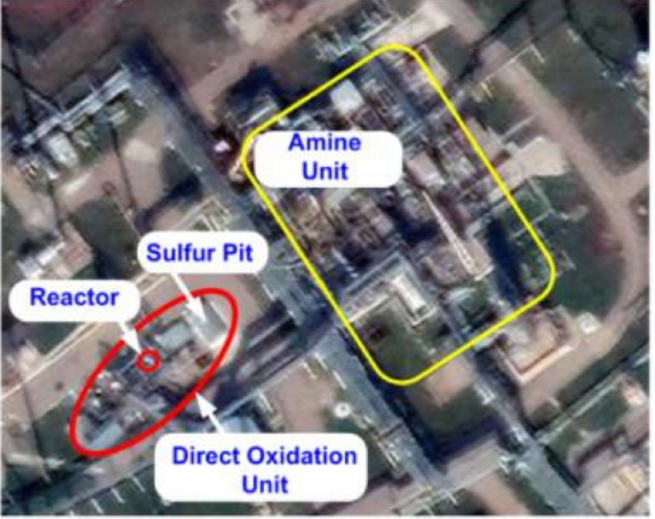
Figure 22. Bavly gas shop of PSC Tatneft. Purification of oil associated gas. Amine treatment and direct oxidation. Source: Satellite